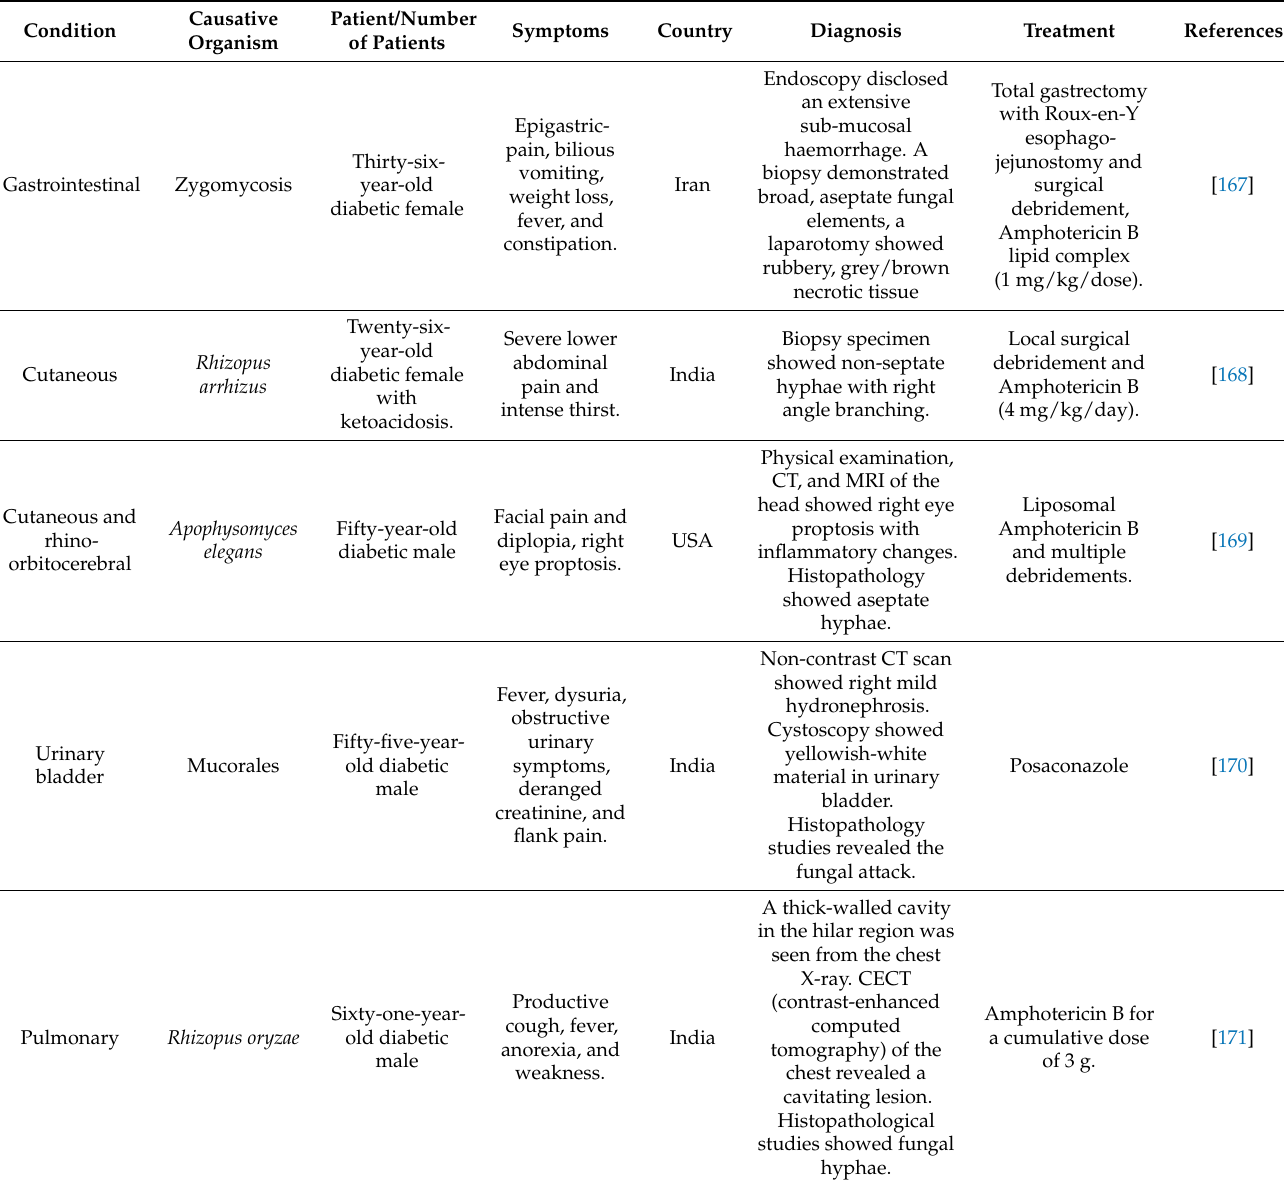
Table 2. Recent studies on zygomycosis cases with diabetic patients and their treatment